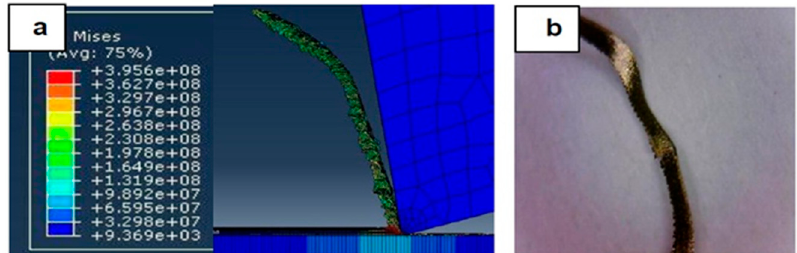
Figure 12. Machining Stainless Steel 316L at feed rate 0.06 mm/rev: ( a ) Chip formation and ( b ) produced chip.